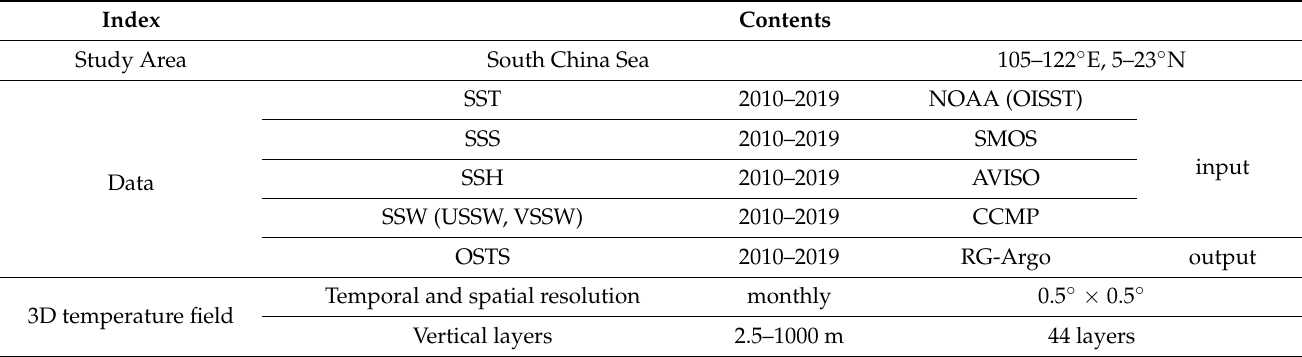
Table 1. Summary of the data used in this